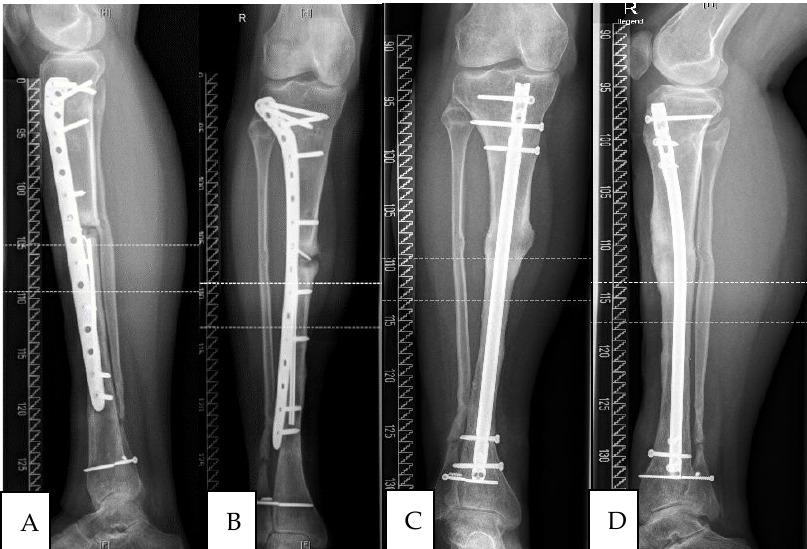
Figure 2. Atrophic tibial non-union (responder) initially treated with locking plate, converted to tibial nail according to diamond-concept, consolidation at 12 months post-op.( A ) lateral view pre-OP; ( B ) ap-view pre-OP; ( C ) ap-view post-OP ( D ) lateral view